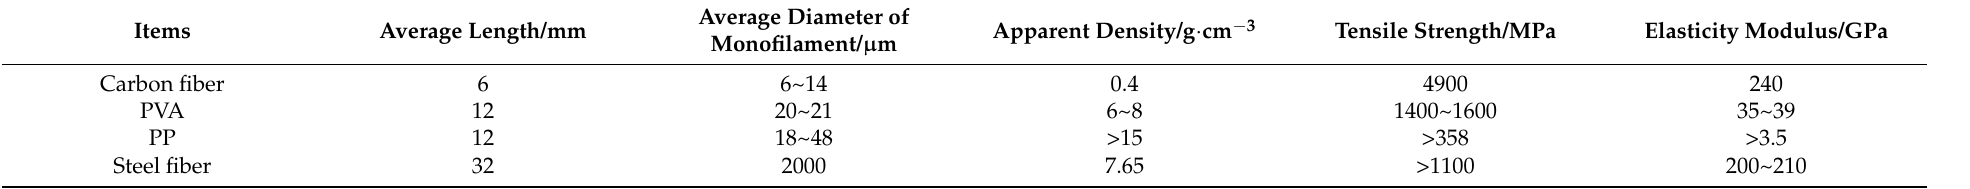
Table 1. Characteristic parameters of the fibers.